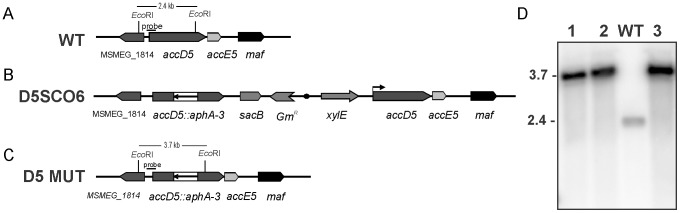
Allelic exchange of the accD5 locus of M. smegmatis.A-C. Genetic organization and partial restriction maps of the accD5 chromosomal region of (A) the wild-type strain mc2155, (B) the single crossover strain D5SCO6, and (C) the M. smegmatis D5DCO conditional mutant. D) Southern blot analysis of M. smegmatis accD5 mutants. Three conditional mutants were picked at random (lanes 1–3), and their chromosomal DNA digested with EcoRI and probed for hybridization with a 390 bp labeled fragment corresponding to the 5′ region of accD5. M. smegmatis mc2155 DNA was included as a control (WT). Molecular masses are indicated in kilobases.